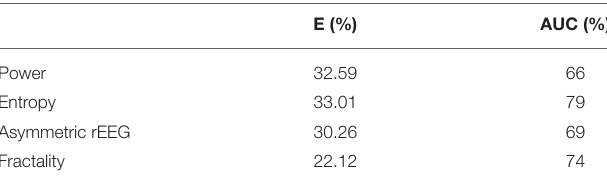
TABLE 3 | Results of the binary classification models developed with linear discriminant